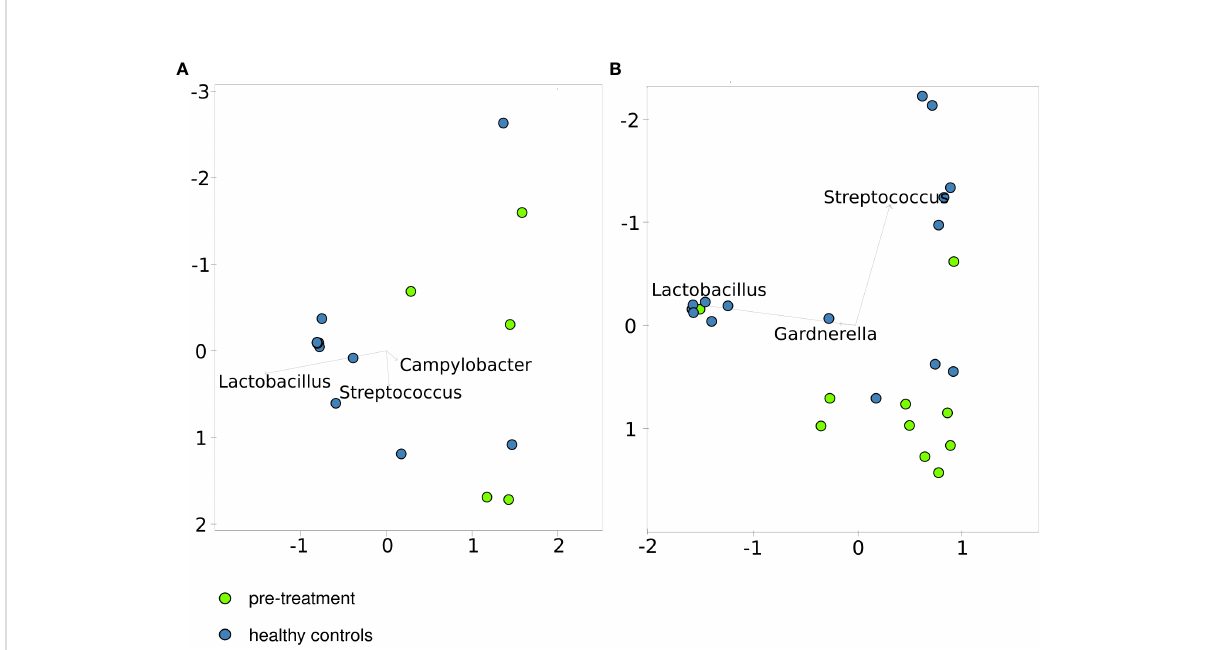
FIGURE 1 Principal coordinates analysis based on the Bray – Curtis index for healthy controls and patients before treatment. - pre-menopausal (A, B) – postmenopausal cases and